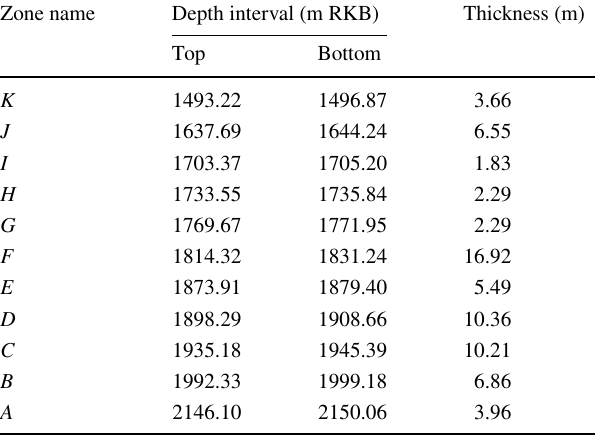
Fig. 2 Workflow on the petrophysical interpretation Table 1 Zones and depth